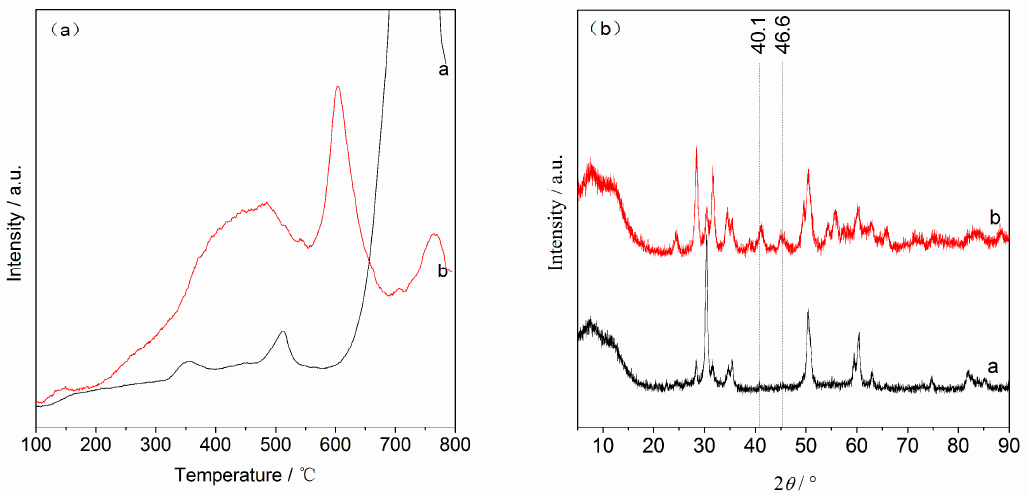
Figure 1. temperature-programmed desorption) patterns ( a ) and XRD patterns ( b ) of the SO 42– /ZrO 2 (a – black peak) and Pd/SO 42– /ZrO 2 (b – red peak).